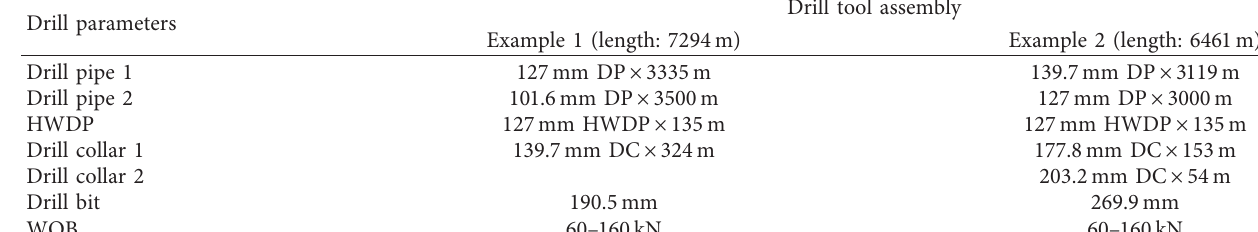
Table 2: Parameters of drilling tool